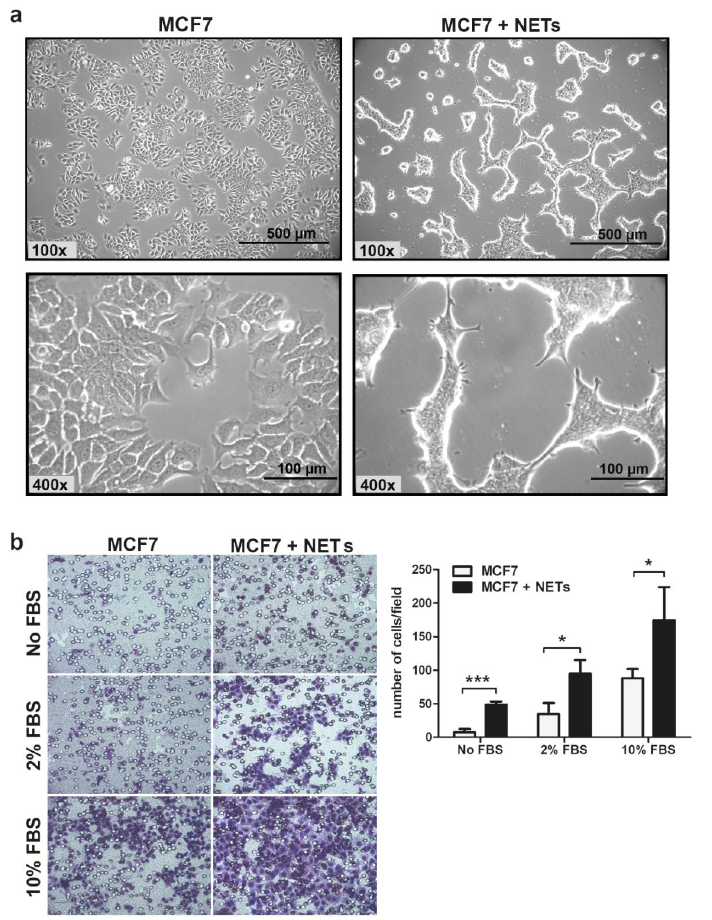
Figure 1. Neutrophil extracellular traps (NETs) alter cell morphology and enhance MCF7 migration in vitro. ( a ) Representative images of MCF7 cells that were cultured for 16 h in the absence (left) or the presence (right) of NETs (500 ng/mL). Magnification 100× and 400×, scale bar 500 µm and 100 µm, respectively. ( b ) Tumor cell migration was evaluated employing the Boyden chamber assay. MCF7 cells that were cultured for 16 h in the absence or the presence of NETs (500 ng/mL) were seeded in the upper chamber (5 × 10 4 cells/well) and further allowed to migrate for 20 h. As chemoattractant, medium supplemented with fetal bovine serum (FBS) (2% or 10%) was used in lower chambers. Representative images of the migration assay are shown on the left panel (200× magnification). Migrated cells were quantified, and results are shown on the right panel. Data are presented as mean ± SD from three independent experiments. Statistical analysis of each condition was evaluated by unpaired t -test. Significance was assumed for * p < 0.05, *** p < 0.001.